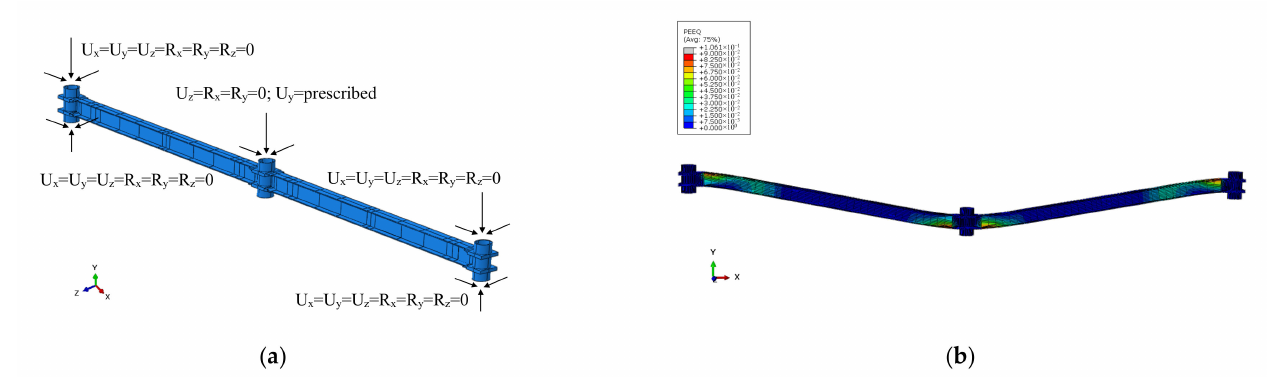
Figure 11. Subassembly two-span frame extracted from model B c (model S): ( a ) Boundary conditions; ( b ) Equivalent plastic strain